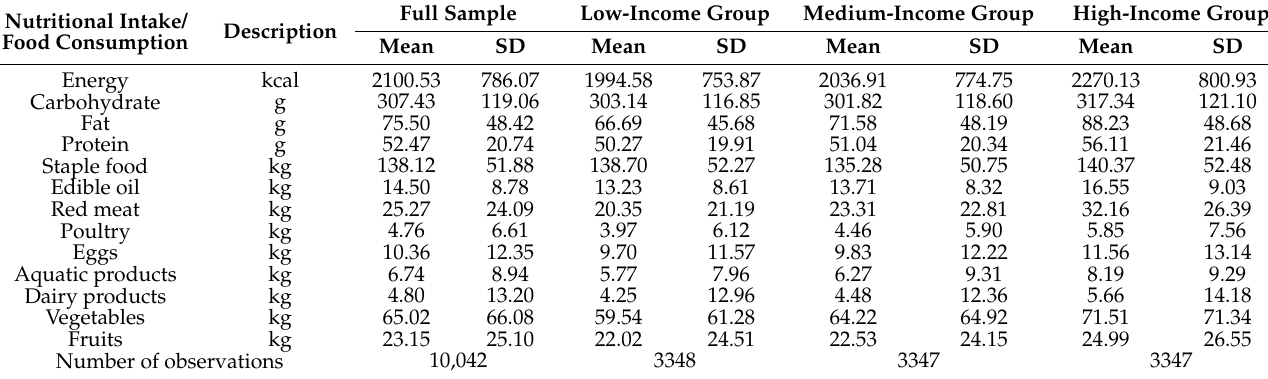
Table A3. Summary statistics of nutritional intake and food consumption by income